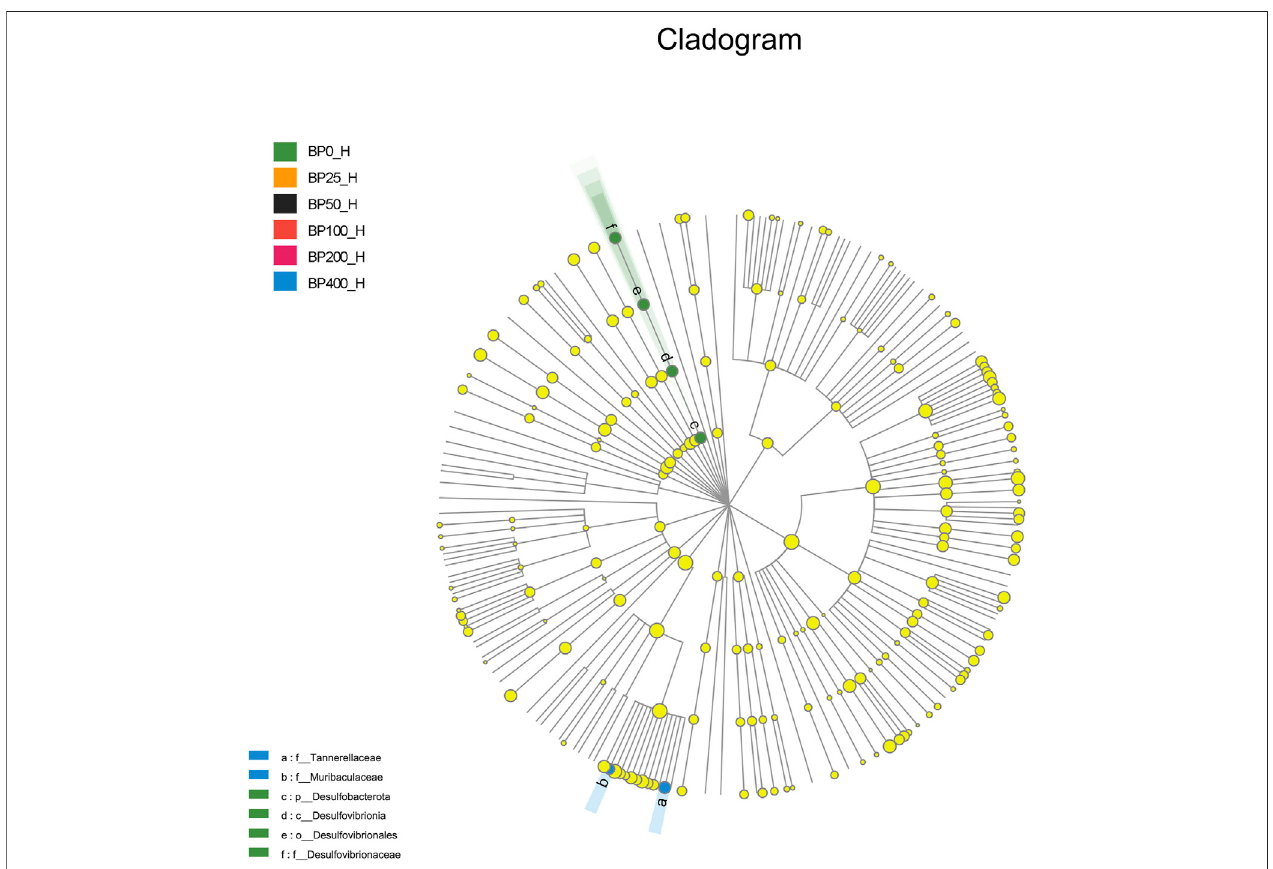
FIGURE 7 | LEfSe analysis of microbiota in